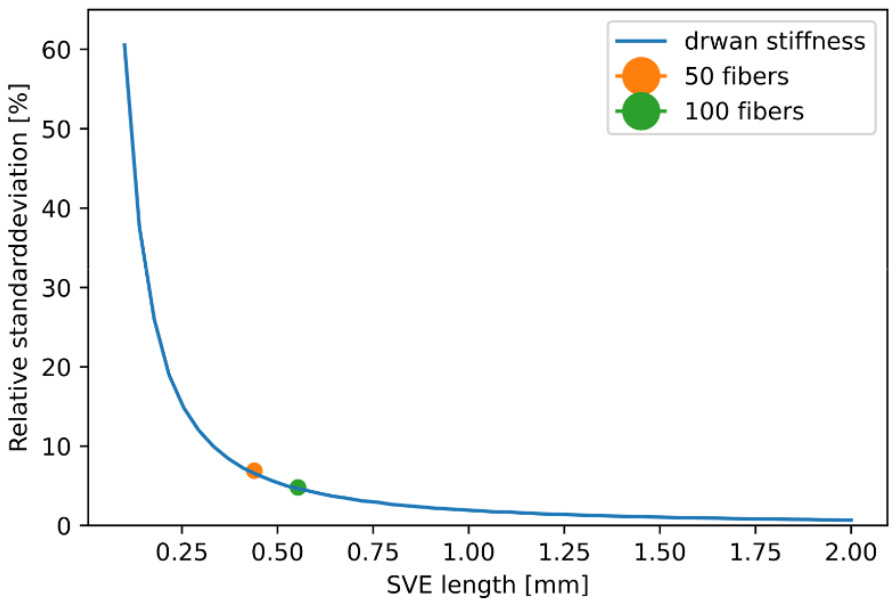
Figure 14. Relative standard deviation of drawn effective stiffness in dependency of considered volume and relative stand- ard deviation of Monte-Carlo simulations with 50 and 100 fibers. volume and relative standard deviation of Monte-Carlo simulations with 50 and 100